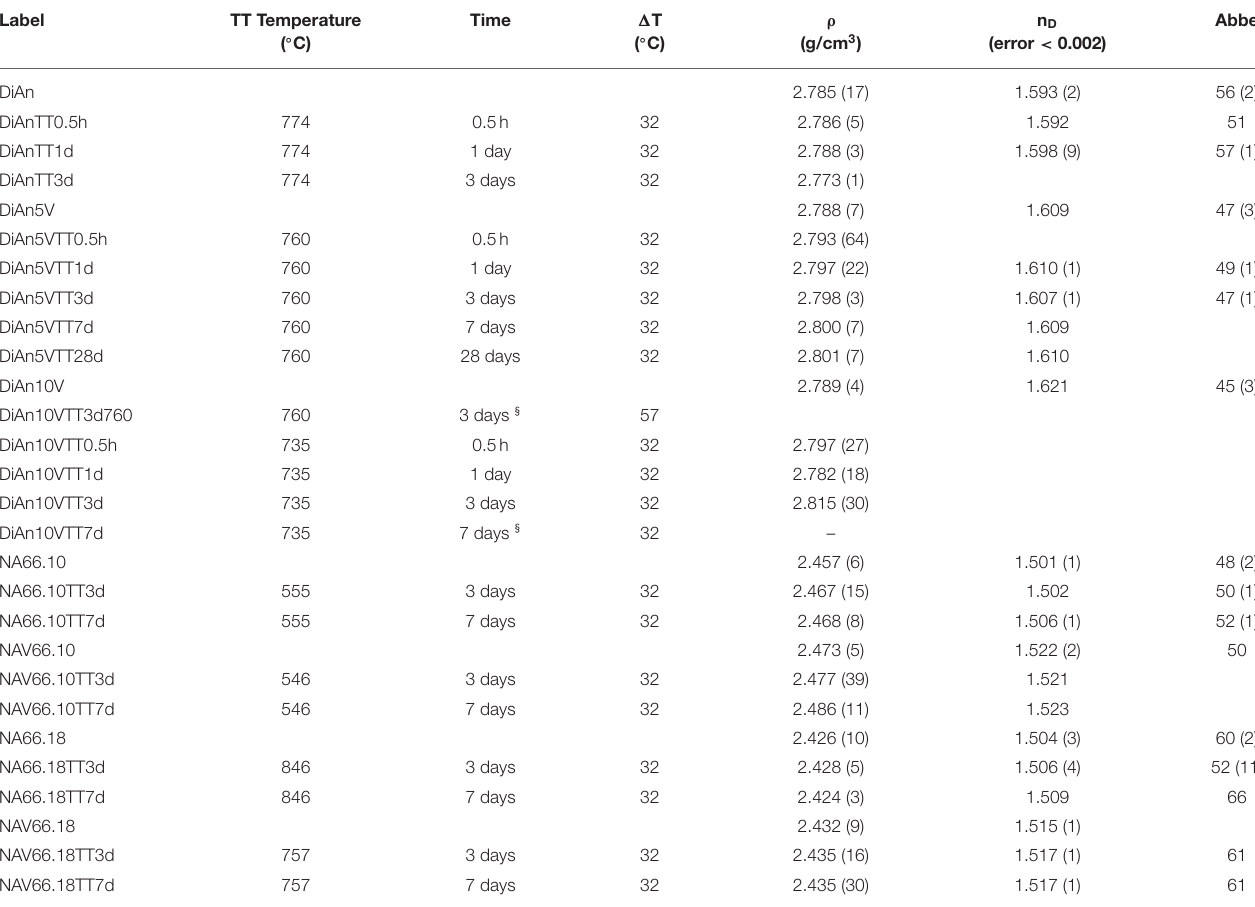
TABLE 2 | Thermal treatment (TT) parameters and properties.